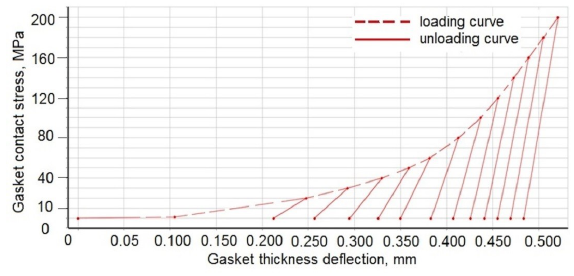
Figure 6: The characteristic of FG_2 gasket describing the